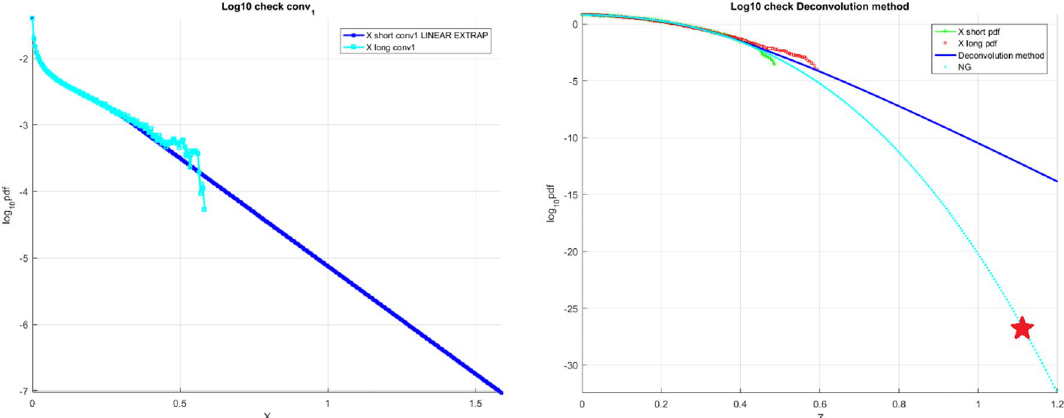
Figure 4. Combined wind speed and wave height data. Left: scaled f X 1 tail on the decimal log scale for the «shorter» data (cyan), linearly extrapolated (dark blue). Right: unscaled raw «shorter» data (green) f X tail on the decimal log scale, extrapolated by deconvolution method (dark blue), along with «longer» raw data (red) and NG extrapolation (cyan). Star indicates 100 years return period Figure 4 on the left presents the «shorter» data record f X tail, obtained by deconvolution as in Eq. (13), and 1 subsequently linearly extrapolated in the terminal tail section to cover the X 1 range matching the «longer» data record. Figure 4 on the right presents final unscaled results of the proposed in this paper technique, namely the «shorter» decimal log scale f X tail, extrapolated by deconvolution, along with «longer» data distribution tail and NG extrapolation. It is seen that NG prediction does not agree with deconvolution approach, leading to non-conservative predic- tion, indicated by star in Fig. 4 on the right. It is seen from Fig. 4 on the right that the proposed method performs quite well, being based on the «shorter» data set, and delivering probability distribution close to the one based on the «longer» data set. Figure 4 on the right presents extrapolation according to Eq. (9) as well novel deconvolution method towards failure state with 100 year return period, which is 1, and somewhat beyond, (cid:31) = 0.05 cut-on value was used. Dotted lines indicate extrapolated 95% confidence interval according to Eq. (10). According to Eq. (5) p ( (cid:31) ) is directly related to the target failure probability 1 − P from Eq. (1). Therefore, in agreement with